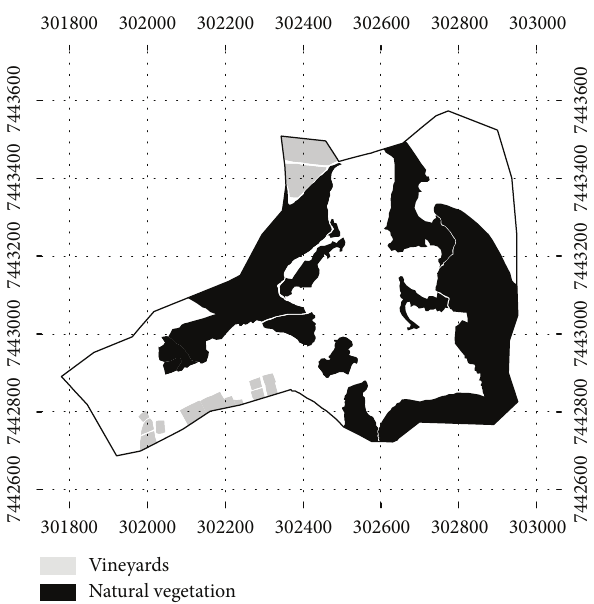
Table 1: Descriptive statistics of soil attributes in the vineyard and other uses in the region studied.